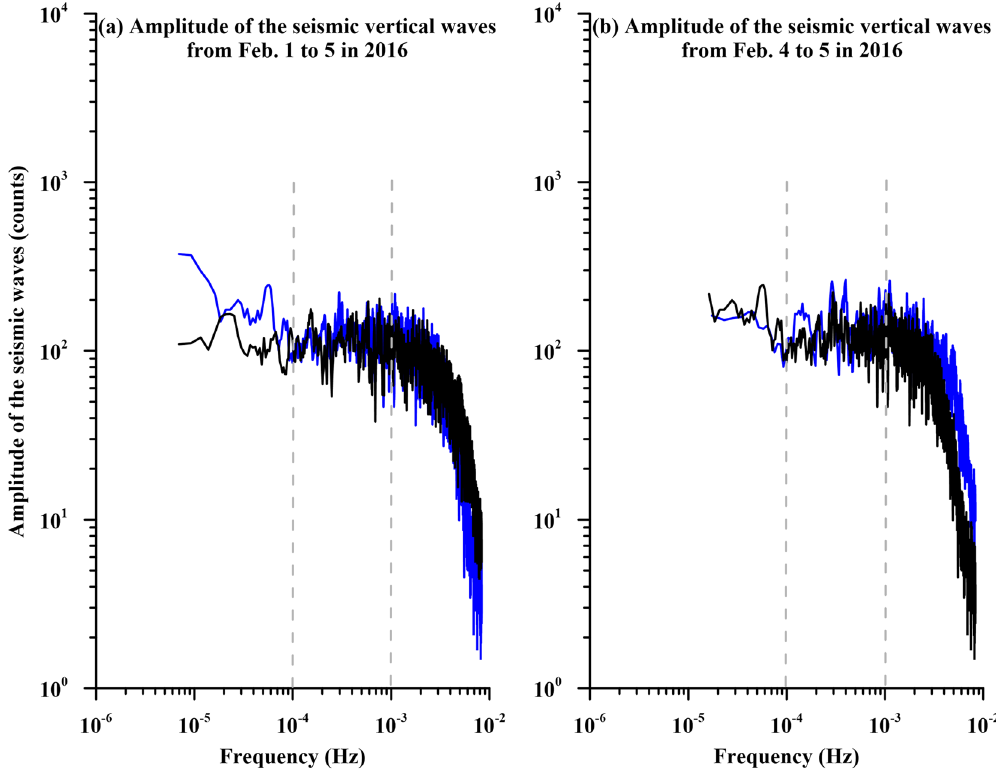
Figure 4. Amplitudes of seismic vertical velocities at the SBCB and TATO stations during the study periods. Seismic vertical velocities during February 1–5 and February 4–5 in 2016 are down sampled to a temporal interval of 1 min and are transferred into the frequency domain using the Fourier transform shown in ( a ) and ( b ), respectively. Notably, the black and blue lines denote variations of the amplitudes with a running average of 5 continuous points at the TATO and SBCB stations, respectively. The vertical dash lines denote the frequency at 10 –4 Hz and 10 –3